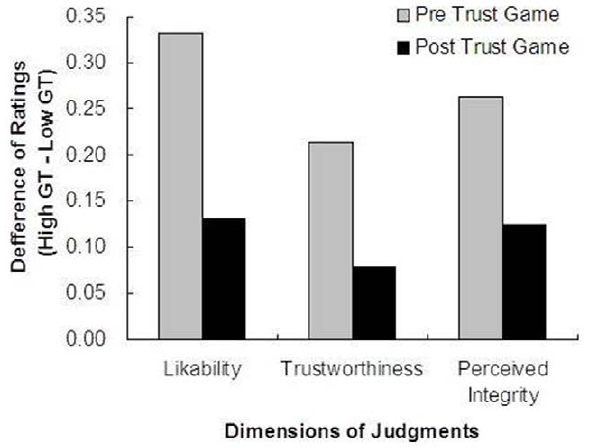
Figure 5. Difference of mean ratings between participants who rated high in general trust ( n=28 ) and low in general trust ( n=24 ) in pre- and post-game partner judgments.